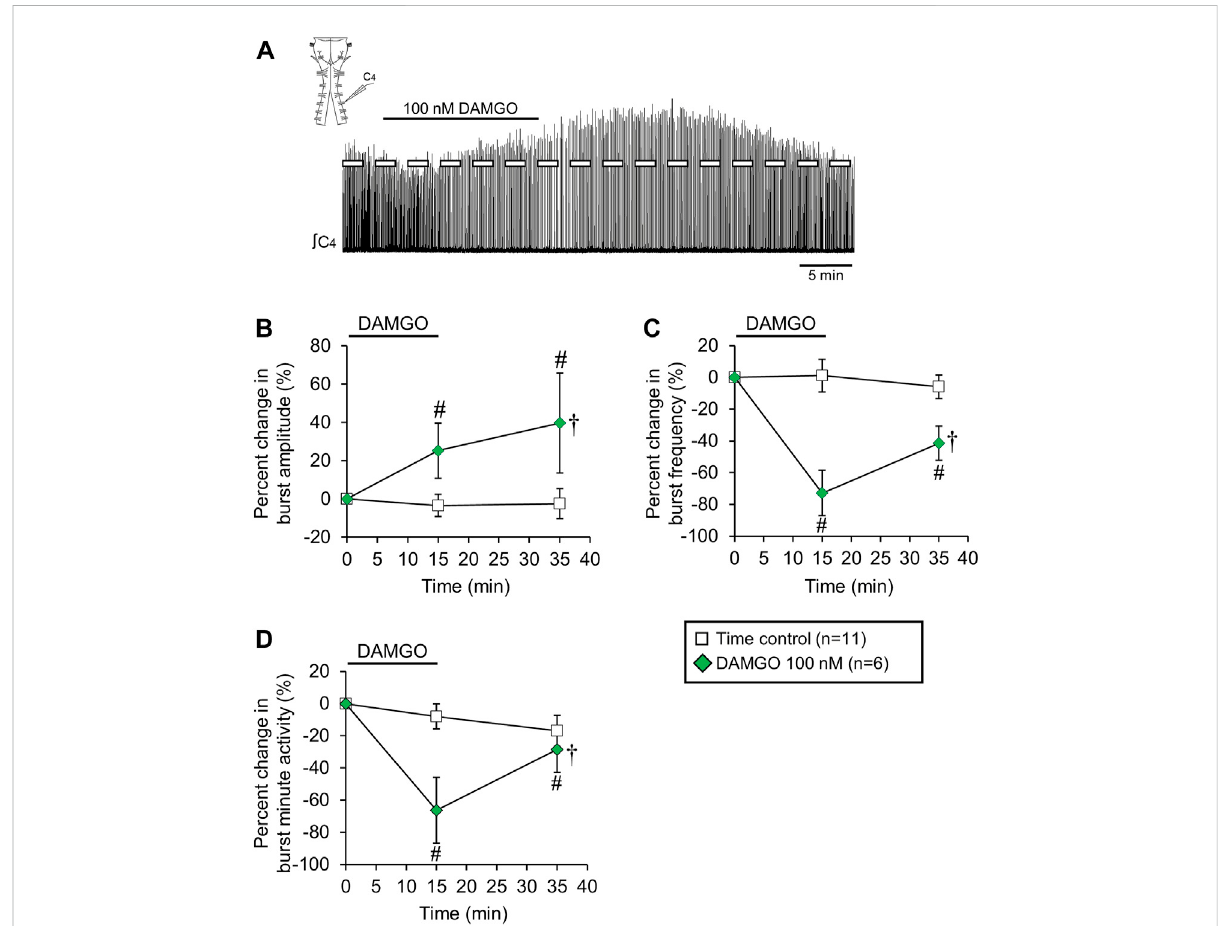
FIGURE 5 Cervical spinal midline-lesion did not alter the DAMGO-induced inspiratory burst amplitude increase. (A) Drawing of a brainstem-spinal cord preparation with the cervical spinal midline-lesion from C3 to C7 with a suction electrode attached at ventral cervical spinal root C4. At right is a sample voltage trace showing DAMGO-induced changes in burst amplitude and frequency. DAMGO (50 – 200 nM; green diamond symbols) increasedburstamplitude (B) anddecreasedburstfrequency (C) comparedtotimecontrols. (D) MinuteactivitywasalsodecreasedbyDAMGO. The pound sign (#) indicates a signi fi cant pairwise comparison difference from time controls at that time point, and the dagger ( † ) indicates a signi fi cant overall DAMGO concentration effect. Data shown as mean ± SD. These data indicate that crossed bulbospinal pathways in the cervical spinal cord at C3-C7 were not necessary for the DAMGO-induced inspiratory burst amplitude